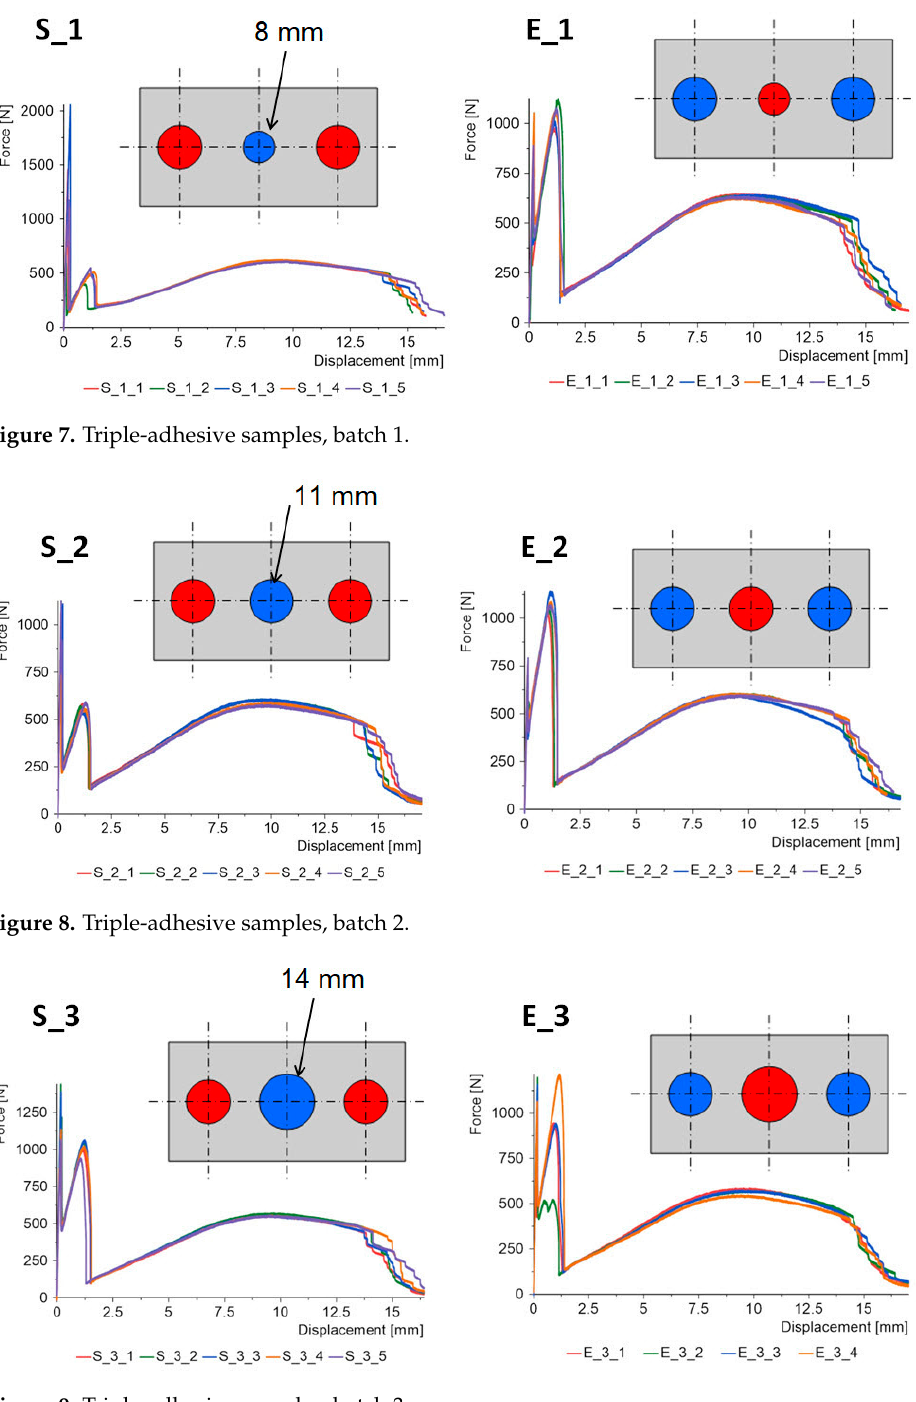
Figure 10. Triple-adhesive samples, batch 4. Figure 11. Triple-adhesive samples, batch 5. By increasing the diameter of the central joint to 11 mm (Figure 8) in the “E” type specimens there is a decrease in the maximum force, while the force for the second stage is slightly increased. In the “S” type specimens, we encounter the phenomenon that the maximum force is reached in the second stage of the work. Another increase in the diameter of the central joint to 14 mm (Figure 9) greatly benefits the “S” type specimens. The strength for the first and second stages increases, but the value for the first stage still dominates. In the “E” type specimens, large variations